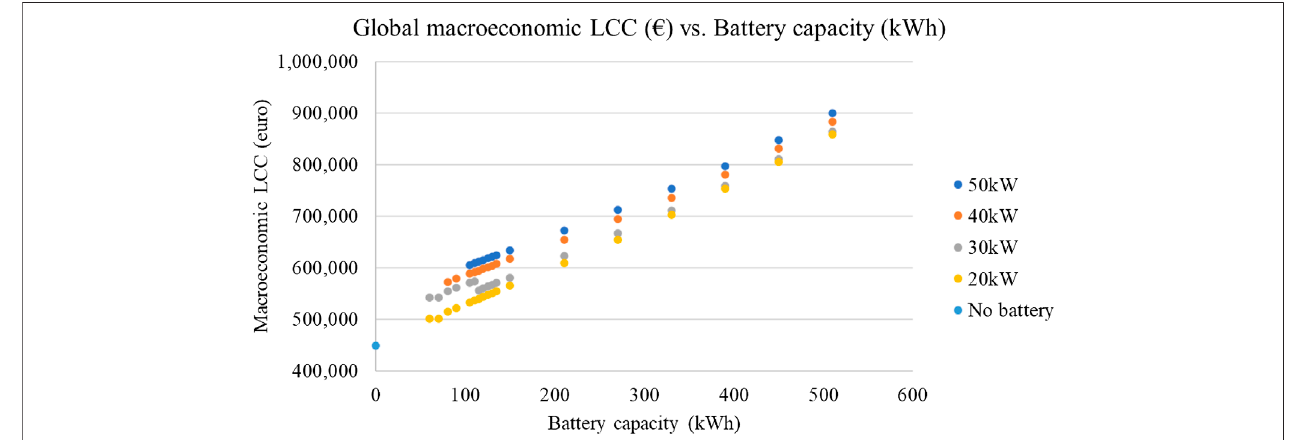
FIGURE 9 | Macroeconomic life cycle cost vs. battery capacity (kWh) for different power